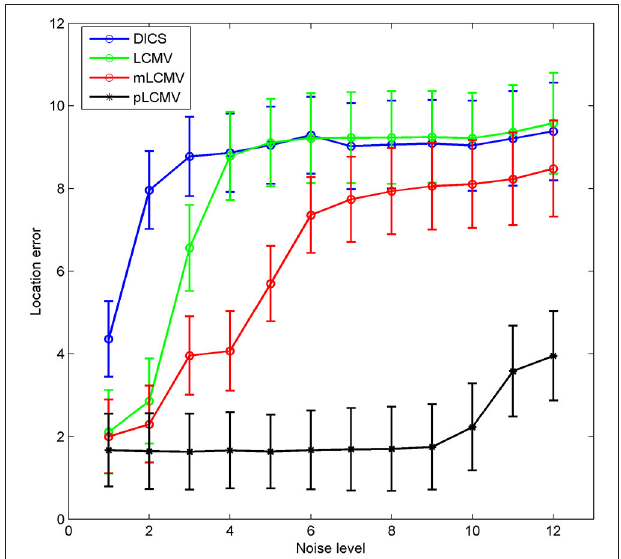
FIGURE 5 | Comparison of the spatial accuracy of the four methods. The x-axis of each plot represents the noise level, and the y-axis represents the mean value ± standard deviation of the location error, based on 309 simulations. Each simulation was generated by a sinc function and Gaussian noise.